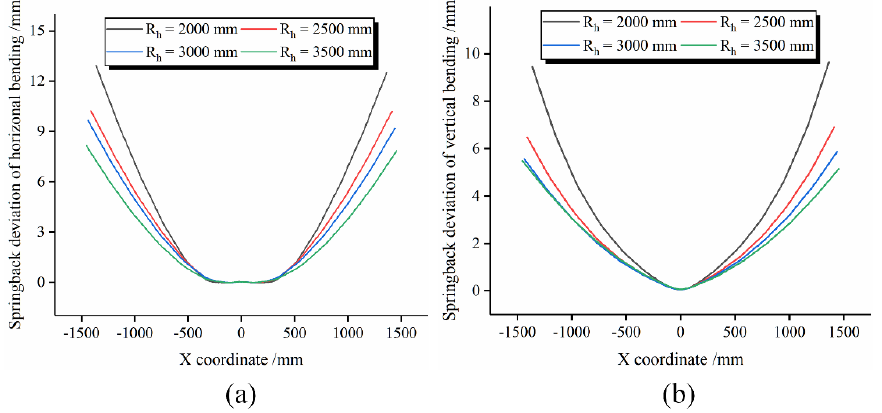
Figure 6. Springback deviation with different horizontal bending radii. ( a ) Springback deviation of horizonal bending. ( b ) Springback deviation of vertical bending.